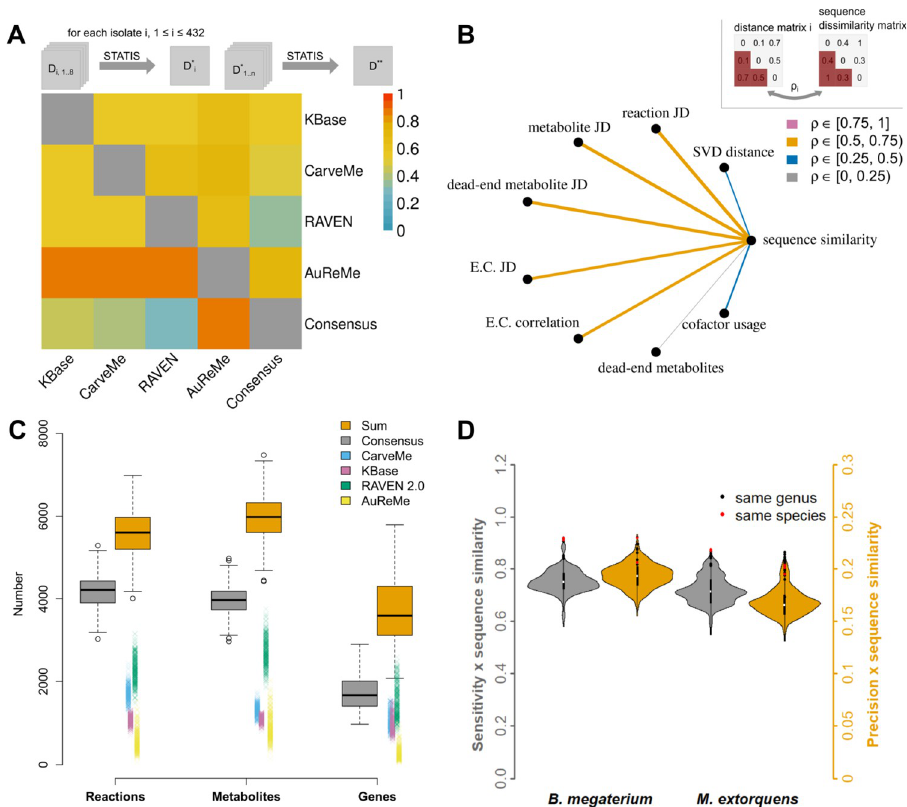
Fig 1. Structural comparisons of draft and consensus reconstructions. (A) Structural differences between the reconstructed draft reconstructions and their consensus. upper triangle: For each isolate i (1 � i � 432) eight distance , 1 � j � 8, see Materials and Methods) were computed for reconstructions from KBase [13], CarveMe [14], matrices ( D i j RAVEN 2.0 [17], AuReMe/ Pathway Tools [15,16],and their consensus. These matrices were then combined for isolate i by finding a compromise matrix D � (STATIS method [40–42]). The resulting compromise matrices were again i combined using STATIS, resulting in a distance matrix D �� capturing the overall difference between pairs of approaches. lower triangle: Gene Jaccard distances between reconstructions across all four methods and the consensus, with compromise distance matrices calculated as for the upper triangle. (B) The same eight distance measures from (A) were used for pairwise comparisons of consensus reconstructions between all isolates (n = 432). Each of the resulting distance matrices was compared to sequence distance of the 16S rRNA sequences using Mantel correlation ( ρ ). The widths and colour coding of the lines connecting the distance measures with sequence similarity indicate the strength of the correlation. (C) Comparison of consensus reconstructions to draft reconstructions. The numbers of reactions, metabolites, and genes are shown for the consensus in comparison to the single draft reconstructions generated by the four approaches. To depict the overlap between the four approaches, the sum of the numbers of reactions, metabolites, and genes per reconstruction is shown (“Sum”, orange box) as the hypothetical number of these features if no reconciliation has happened. (D) Similarity of consensus reconstructions to selected reference models. The sensitivity (grey, left) and precision (orange, right) with respect to metabolite and E.C. number sets were calculated for each of the 432 reconstructions and each reference model. These values were scaled by the sequence similarity to the 16S rRNA sequences of the used references. Isolates that were assigned the same genus (9 for B. Megaterium and 27 for M. extorquens ) or species (2 for B. Megaterium and 5 for M. extorquens ) according to Bai et al. [38], are shown as black or red